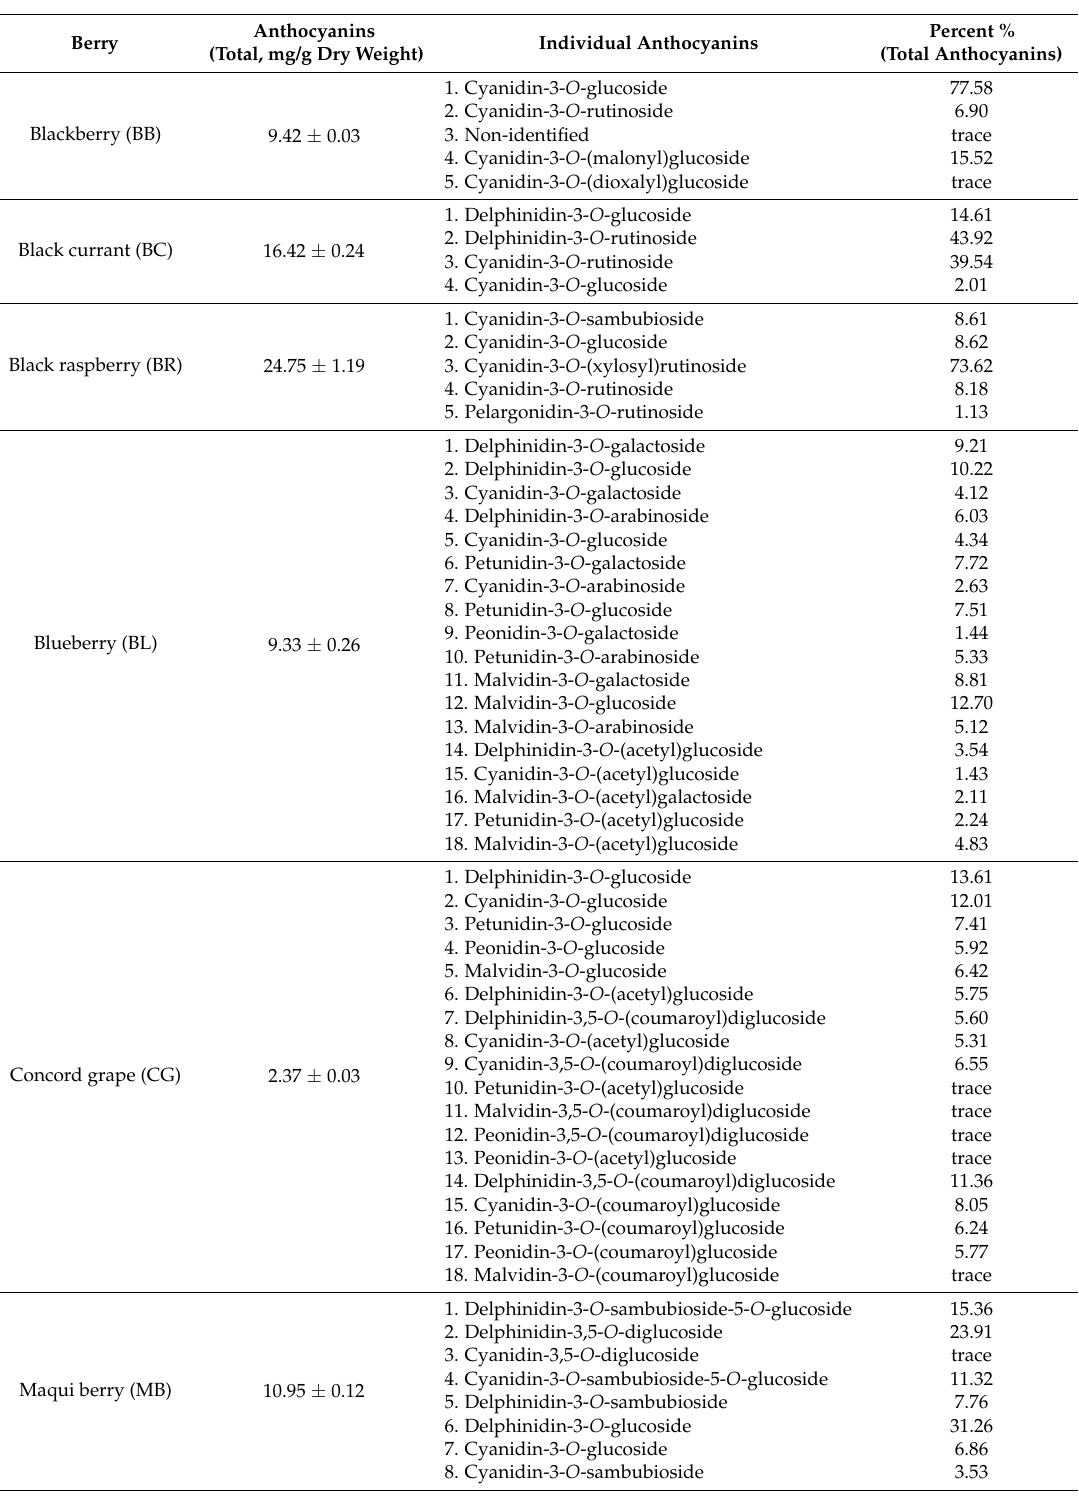
Table 1. Anthocyanin profiles of whole freeze-dried berry powders. Total anthocyanins were determined by the pH differential [25], while individual peaks were quantified by HPLC